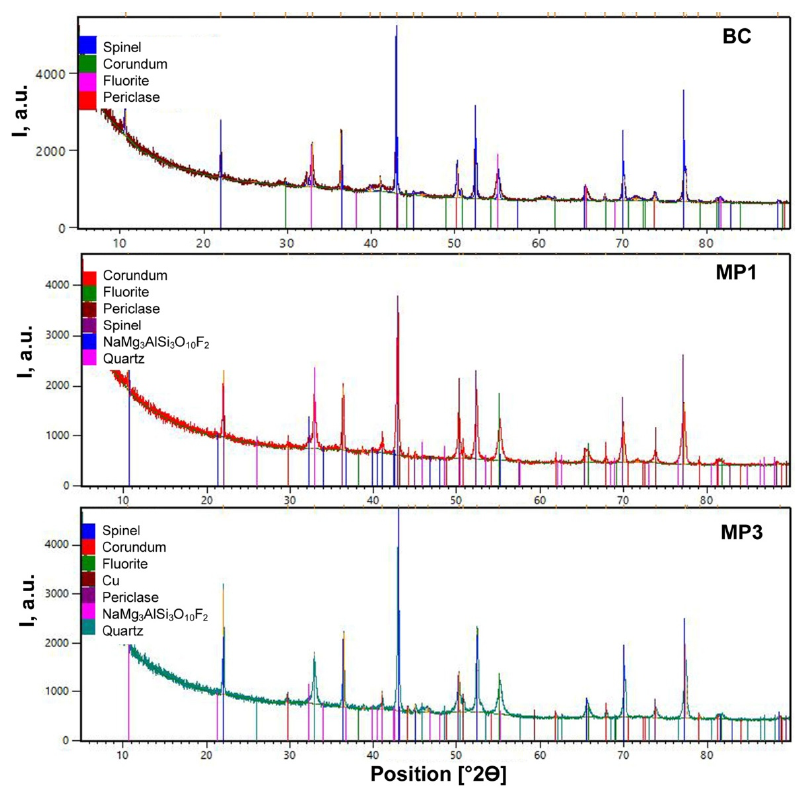
Figure 1. Analysed XRD patterns of post-weld slags in Table 3.